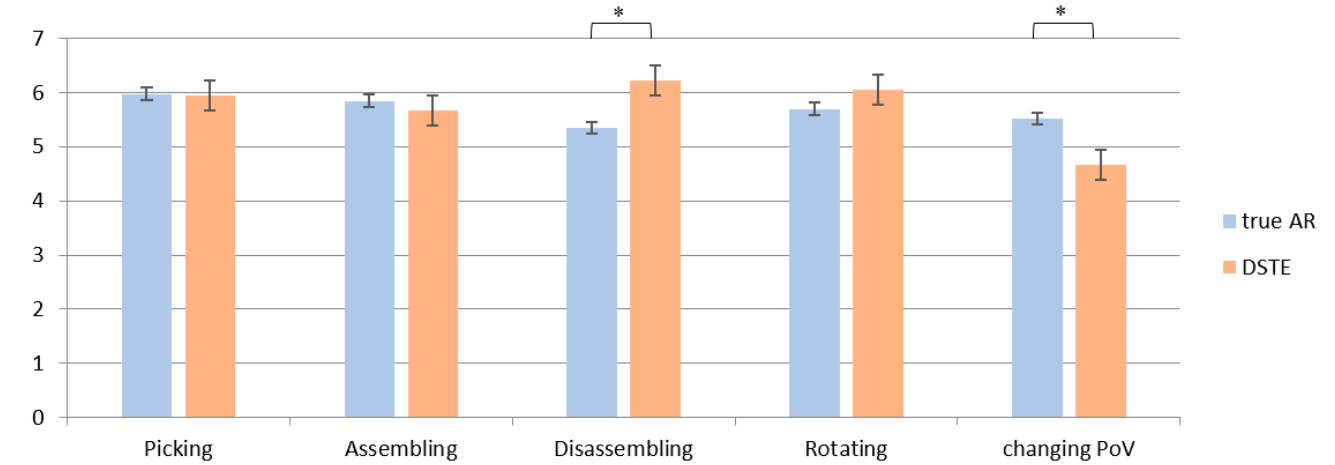
Figure 7. The User Experience Questionnaire (UEQ) scores reported by participants compared to the UEQ benchmark [22].